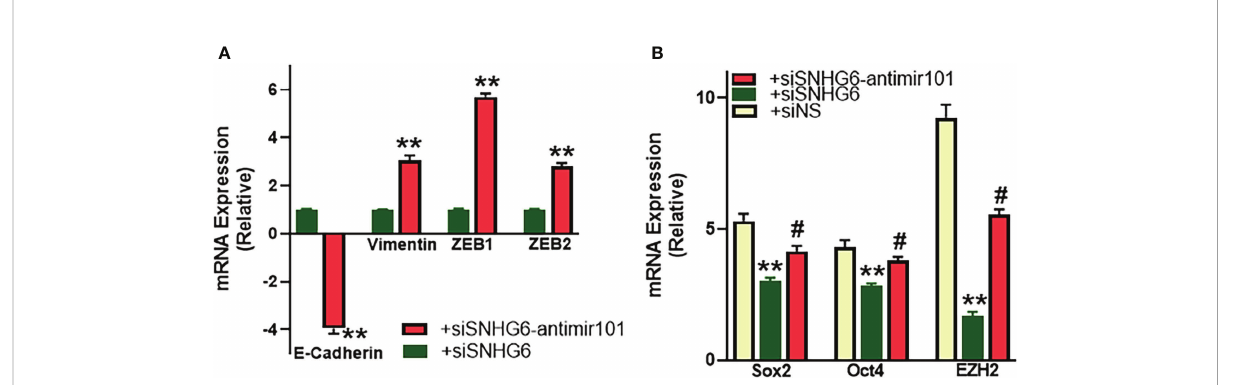
FIGURE 5 miR-101 affects EMT and cancer stem cell markers. (A) MCF7TR cells were silenced for SNHG6 and then the levels of EMT markers, E-cadherin, vimentin, ZEB1 and ZEB2 were evaluated by qRT-PCR in these cells as well as cells that were additionally transfected with anti-miR-101 oligomers. The levels of markers in SNHG6-silenced cells were assigned a value of 1 and the relative levels in siSNHG6+anti-miR-101- transfected cells are plotted. (B) Molecular markers of cancer stem cell phenotype, Sox2, Oct4 and EZH2 were quantitated, using qRT-PCR. The levels of miRNAs in parental MCF-7 cells were assigned a value of 1 and the relative levels in tamoxifen-resistant control MCF7TR (siNS) and those silenced for SNHG6 with and without additional transfections with anti-miR-101, are plotted. **p<0.01, compared to siNS, #p<0.01, compared to